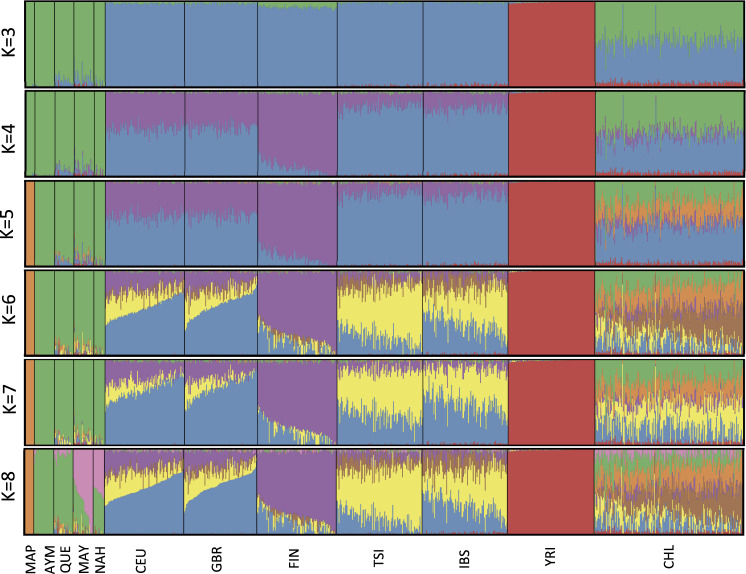
Global ancestry proportions of Chileans, European, Native American, and African populations. Cluster analysis generated by qpas for Chileans as well as a set of Native American, European, African, and Chilean populations. The number of displayed clusters is K = 3–8.